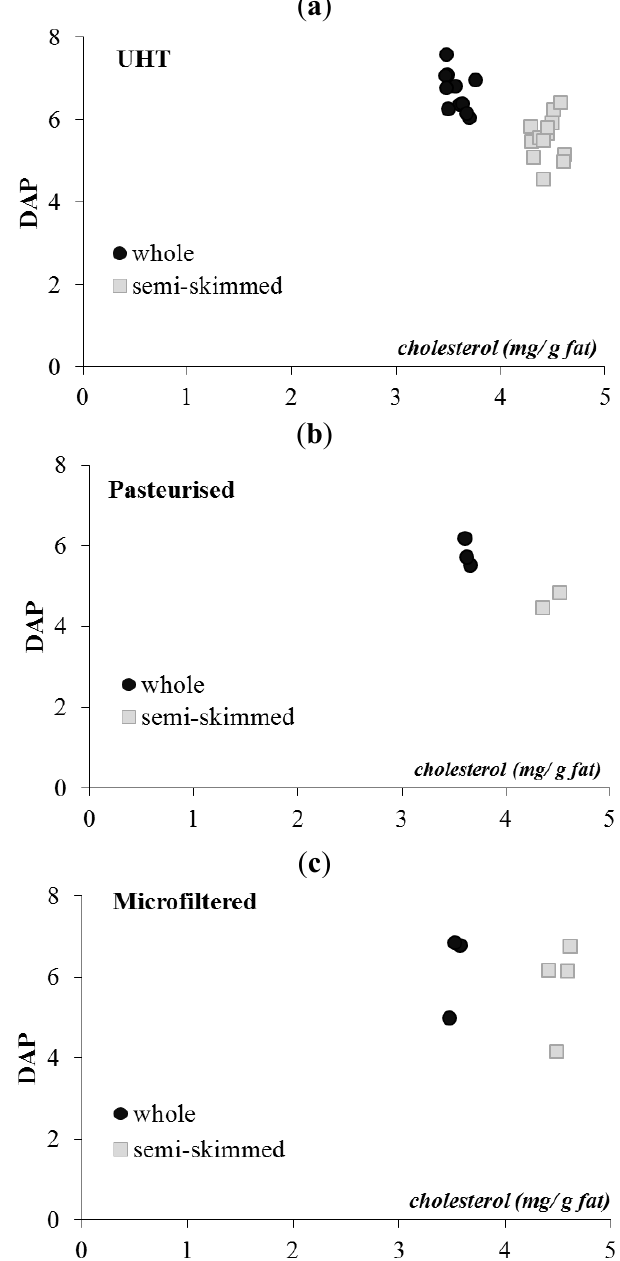
Figure 3. Degree of antioxidant protection (DAP) vs. cholesterol content (mg/g fat) in Whole and semi-skimmed commercial UHT ( a ), pasteurized ( b ) and microfiltered ( c ) milk